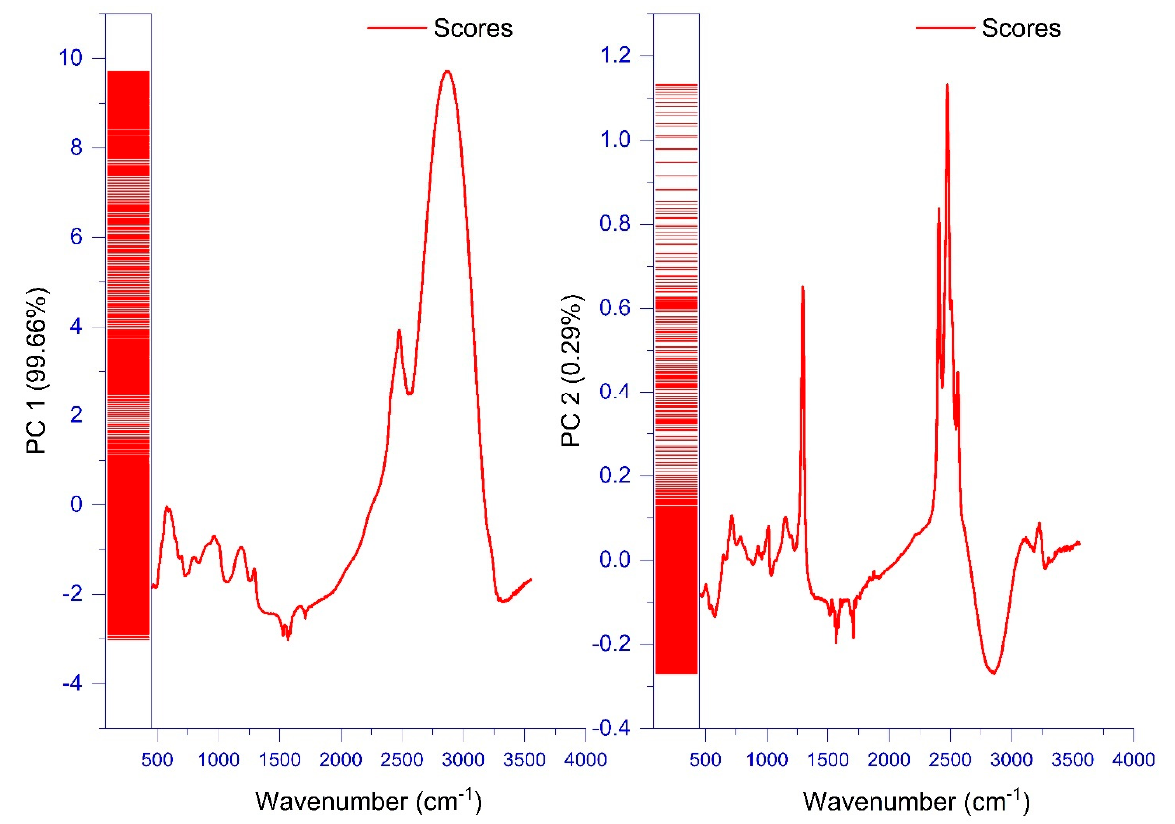
Figure 9. Loadings of each wavelength number in the PCA model total variance for the investigated fig samples. Table 7. Eigenvectors of principal component axes from PCA analysis.